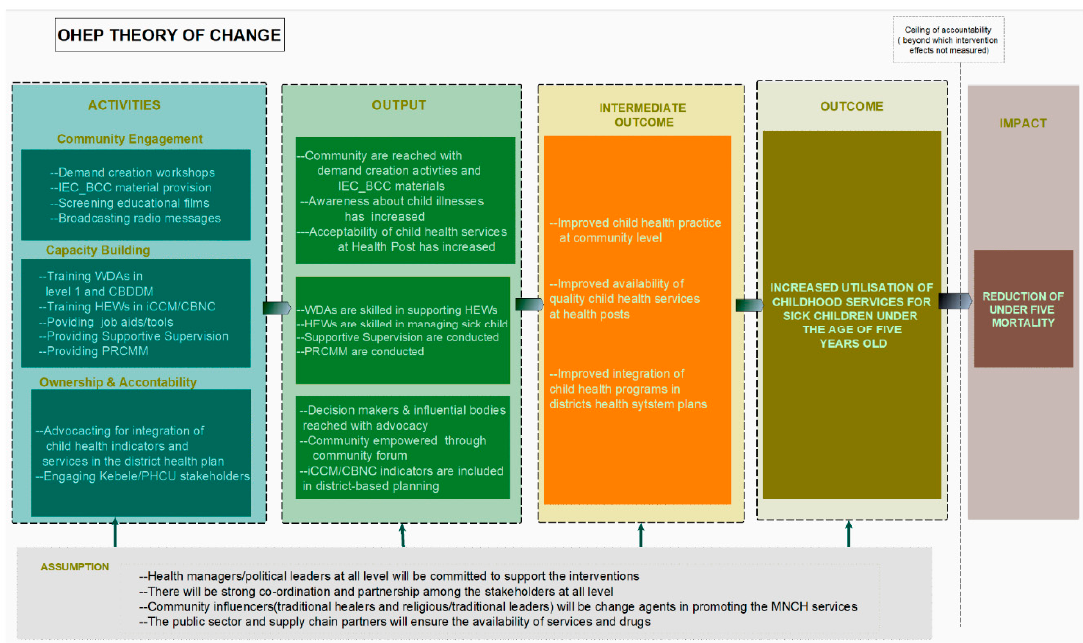
Figure 1. Simplified Theory of Change for the ‘Optimising the Health Extension Program’, to